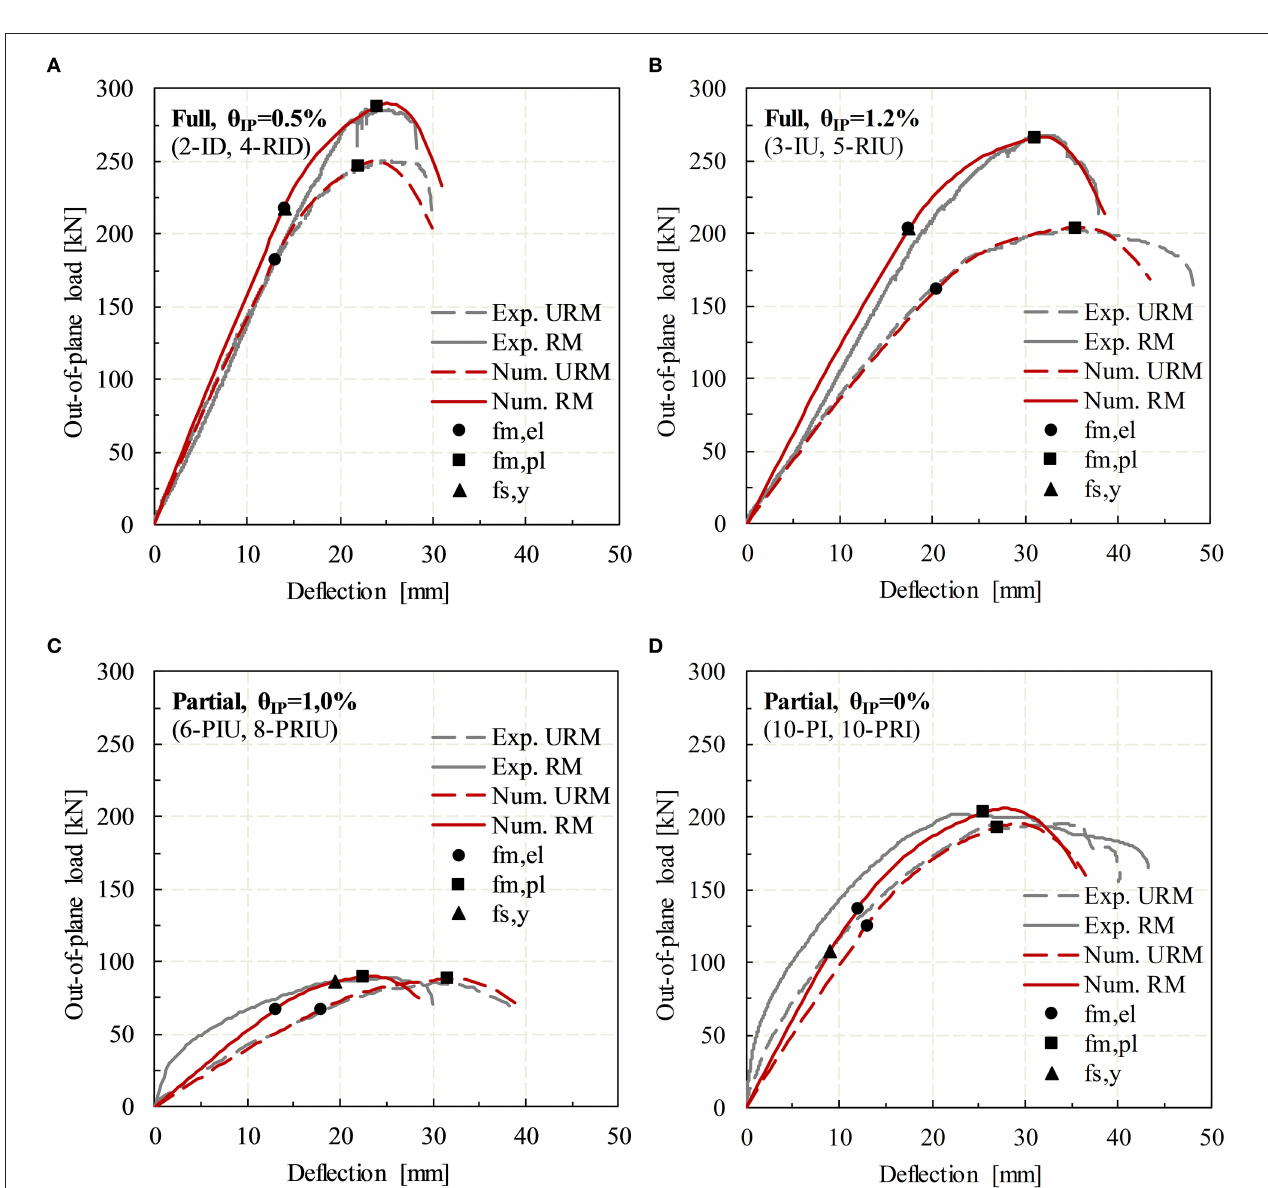
FIGURE 17 | Comparison between experimental and numerical results: unreinforced masonry (URM) and reinforced masonry (RM) full specimens damaged at 0.5% in-plane (IP) drift (A) and 1.2% IP drift (B) ; URM and RM partial specimens damaged at 1.0% IP drift (C) and without previous IP damage (D) .